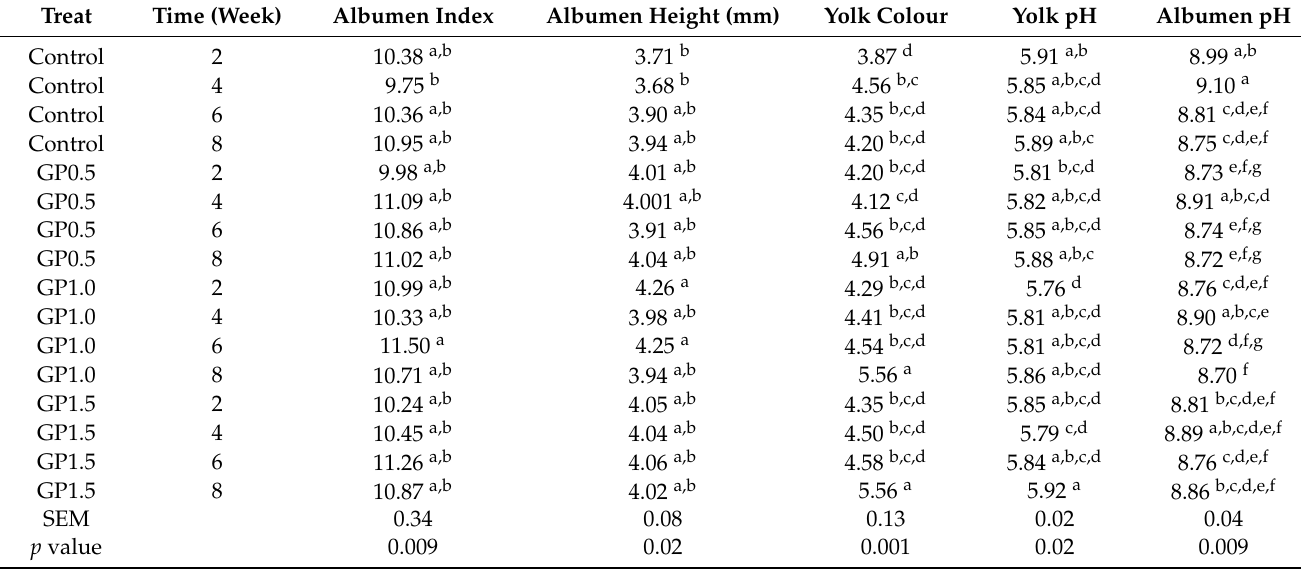
Table 5. Effect of treatment and time Interaction on egg albumen and yolk traits in Japanese quails fed different level of ginger root